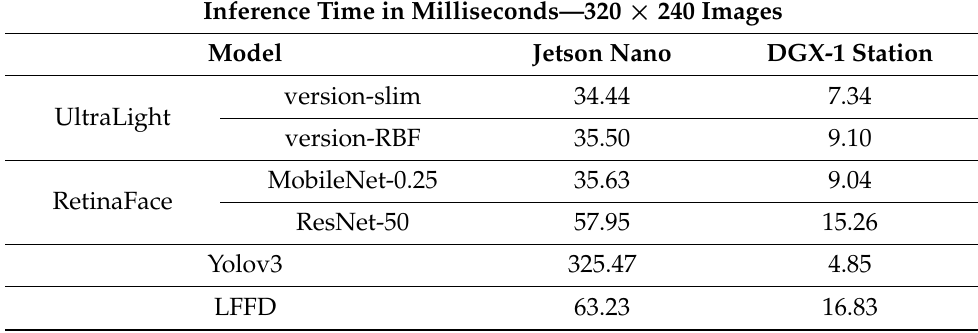
Table 8. Inference time for images with a resolution of 320 ×